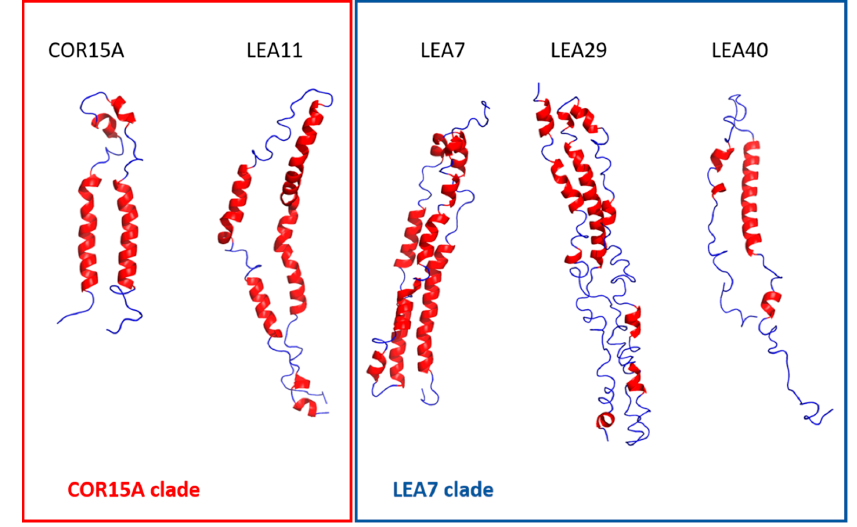
Figure 9. Representative models after 500 ns molecular dynamics (MD) simulations in 100% glycerol in ribbon style. α -helices are colored in red, random coil in blue. Int. J. Mol. Sci. 2020 , 21 , x FOR PEER REVIEW